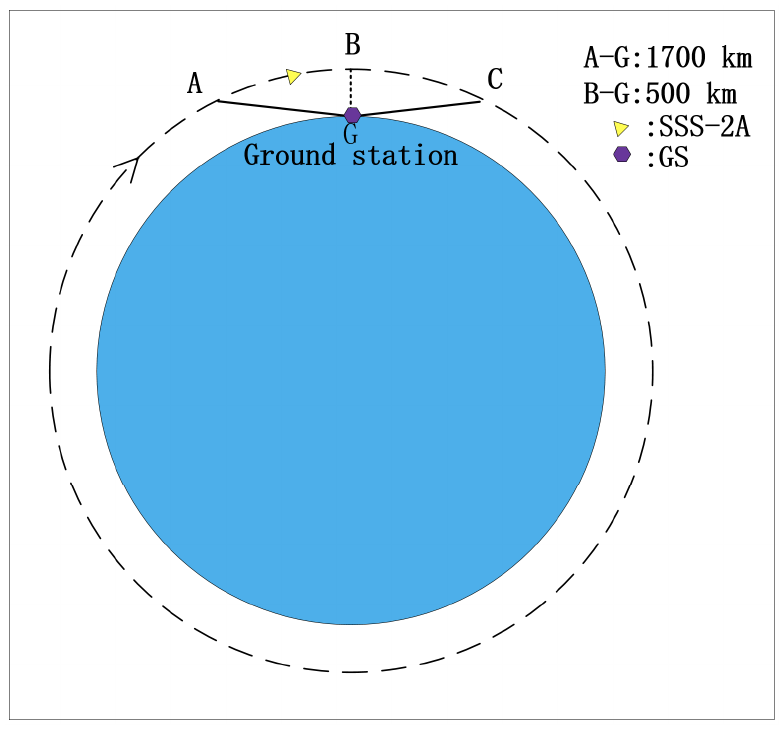
Figure 1. Sun-synchronous orbit (SSO) feature.